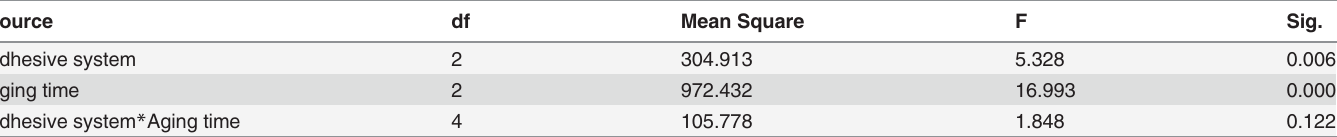
Table 5. Results of two-way (adhesives vs. time) analysis of variance (ANOVA) ( α = 0.05). Source df